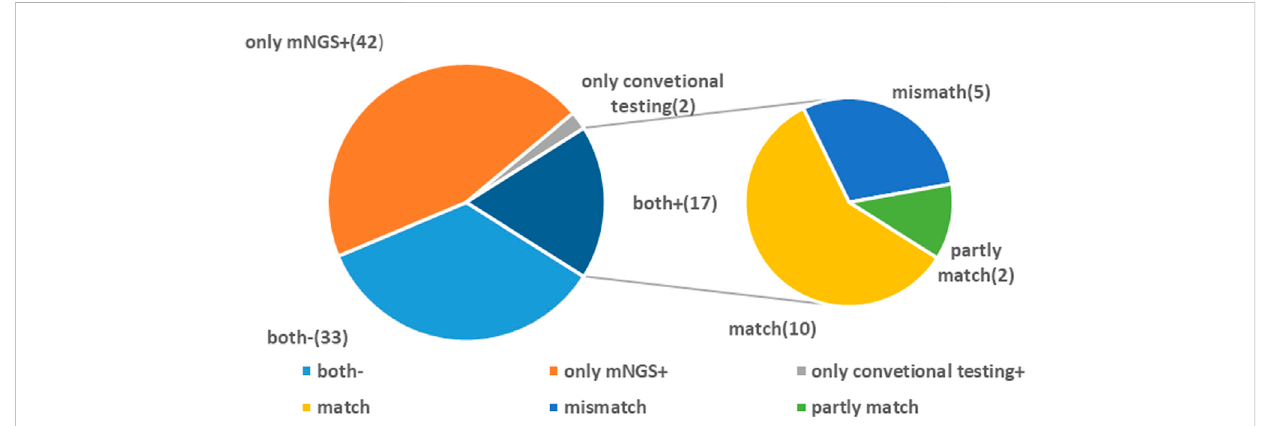
FIGURE 1 Concordancebetweenmetagenomicnext-generationsequencing(mNGS)andconventionaltesting.Both+,bothmNGSandtraditionaltests were positive; both − , both mNGS and traditional tests were negative; mNGS +, only the mNGS result was positive, while traditional test result was negative; only conventional testing +, only the traditional test result was positive, while mNGS was